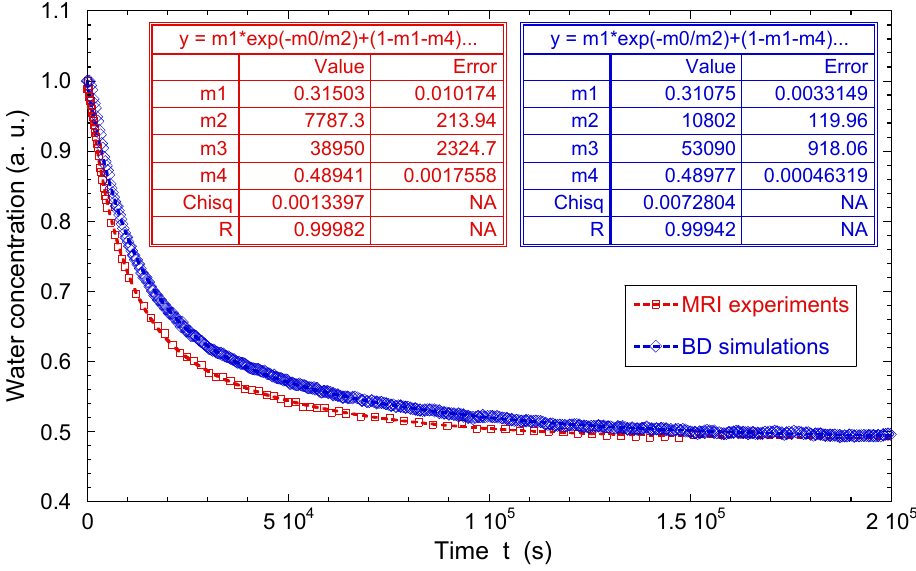
Figure 21. Direct comparison of the time evolutions of the measured and simulated numbers of confined water molecules. Experimental and numerical data are fitted by a biexponential law: f ( t ) = m 1 exp ( − t / m 2 ) + ( 1 − m 1 − m 4 ) exp ( − t / m 3 ) + m 4 , where m i are constants. Reprinted